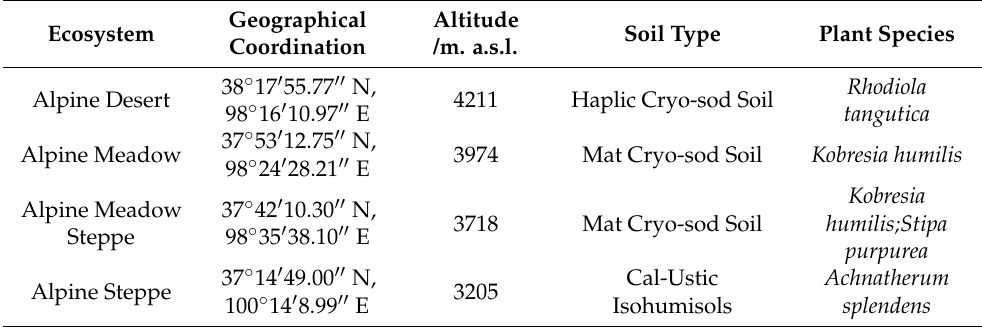
Table 1. Information regarding location, altitude, soil, and vegetation in four ecosystems. The soil was classified according to the Chinese soil